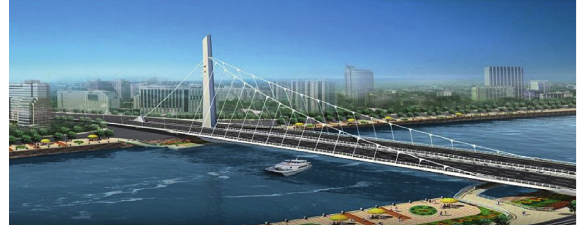
Figure 4: A view of Fumin bridge [23,